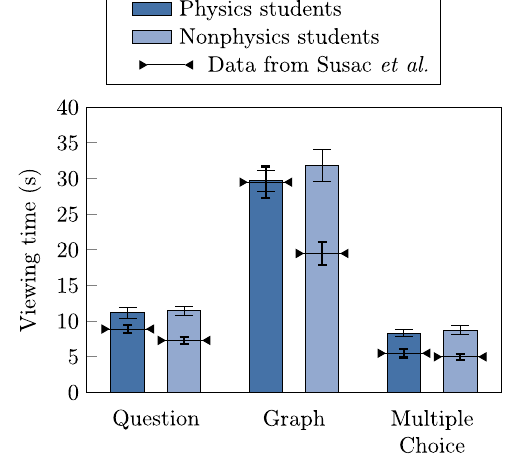
FIG. 7. Average viewing time of physics and nonphysics students on the AOIs Question , Graph , and Multiple choice . The bar graphs represent data obtained in this study and refer to physics and economics students, whereas the triangles represent the data from Susac et al. , referring to physics and psychology students. The error bars represent 1 SEM.